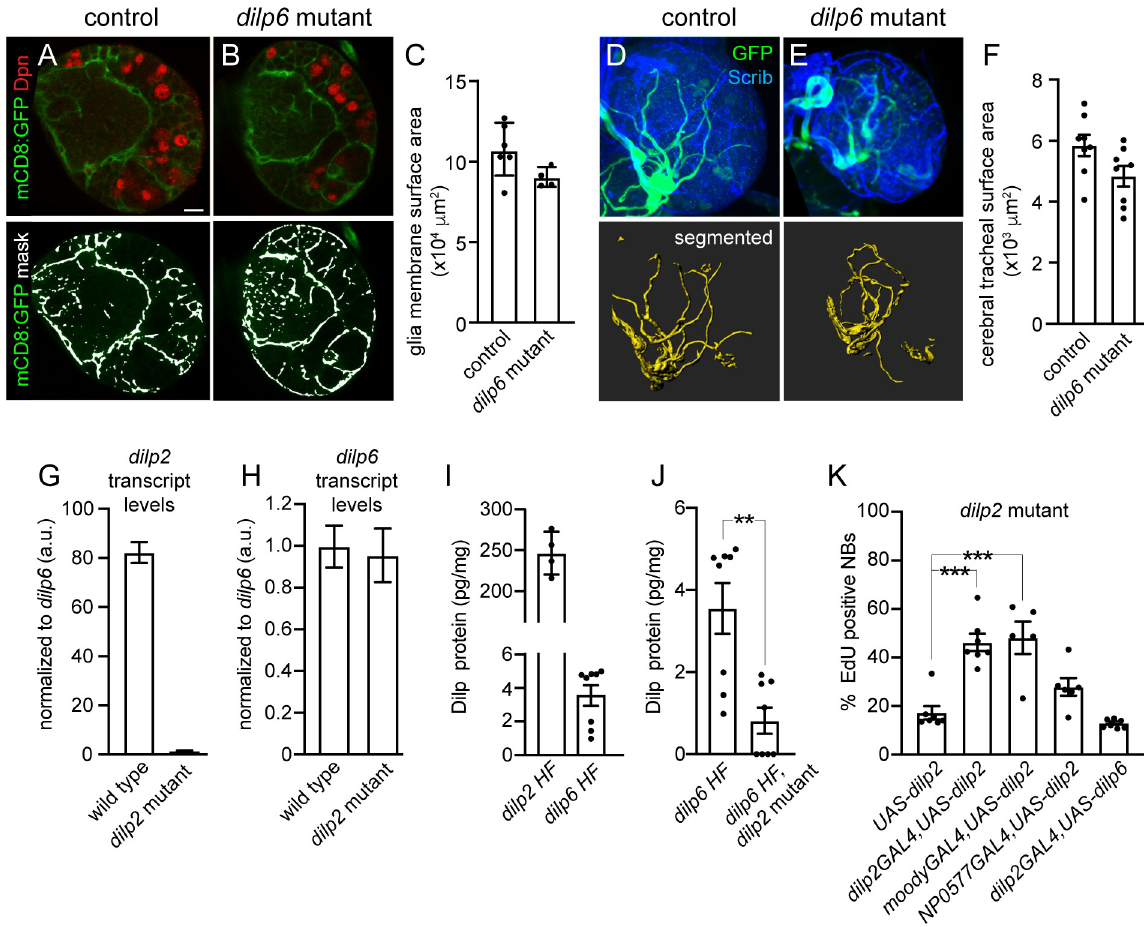
Fig 6. Dilp-2 regulates Dilp-6 CNS protein levels. (A–C) Glial membrane morphology after 24 hours of feeding in controls and dilp6 mutants. (A,B) Single Z images of brain hemispheres. Panels are colored overlays (top) and single-channel images with mask overlays (bottom) used for quantification of total glial membrane surface (C). (D–F) Cerebral tracheal morphology after 24 hours of feeding in controls and dilp6 mutants. (D,E) Maximum intensity projections of brain hemispheres with rendered trachea below and quantified in (F). (G,H) RT-qPCR analysis of dilp2 and dilp6 transcript levels in the CNS of wild-type and dilp2 mutant animals after 24 hours of feeding. Transcript levels of dilp2 and dilp6 are normalized to Gapdh1 and then to dilp6 levels in wild-type animals. (I,J) Brain Dilp-2 and Dilp-6 protein levels, normalized to total brain protein, in wild-type and dilp2 mutant animals after 72 hours of feeding. (K) Quantification of EdU-positive NBs in the indicated genotypes after 24 hours of feeding. (C,F,J) Student two-tailed t test; (K) one-way ANOVA with Tukey post hoc analysis and �� p < 0.01, ��� p < 0.001. Genotypes of panels listed in S2 Table and data listed in S1 Data. a.u., arbitrary unit; CNS, central nervous system; Dilp, Drosophila insulin-like peptide; Dpn, Deadpan; EdU, 5-ethynyl-2 0 -deoxyuridine; Gapdh1 , Glyceraldehyde-3-phosphate dehydrogenase; GFP, green fluorescent protein; HF, HA-FLAG tag; mCD8, membrane-targeted CD8 antigen; NB, neuroblast; RT-qPCR, real-time qPCR; Scrib, Scribble; UAS , upstream activating